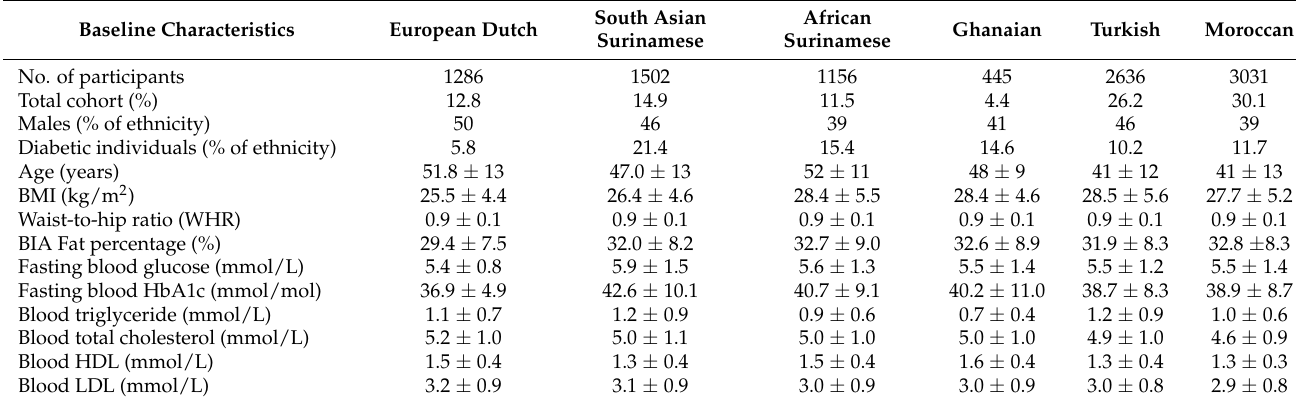
Table 1. Baseline characteristics of the HELIUS cohort stratified by